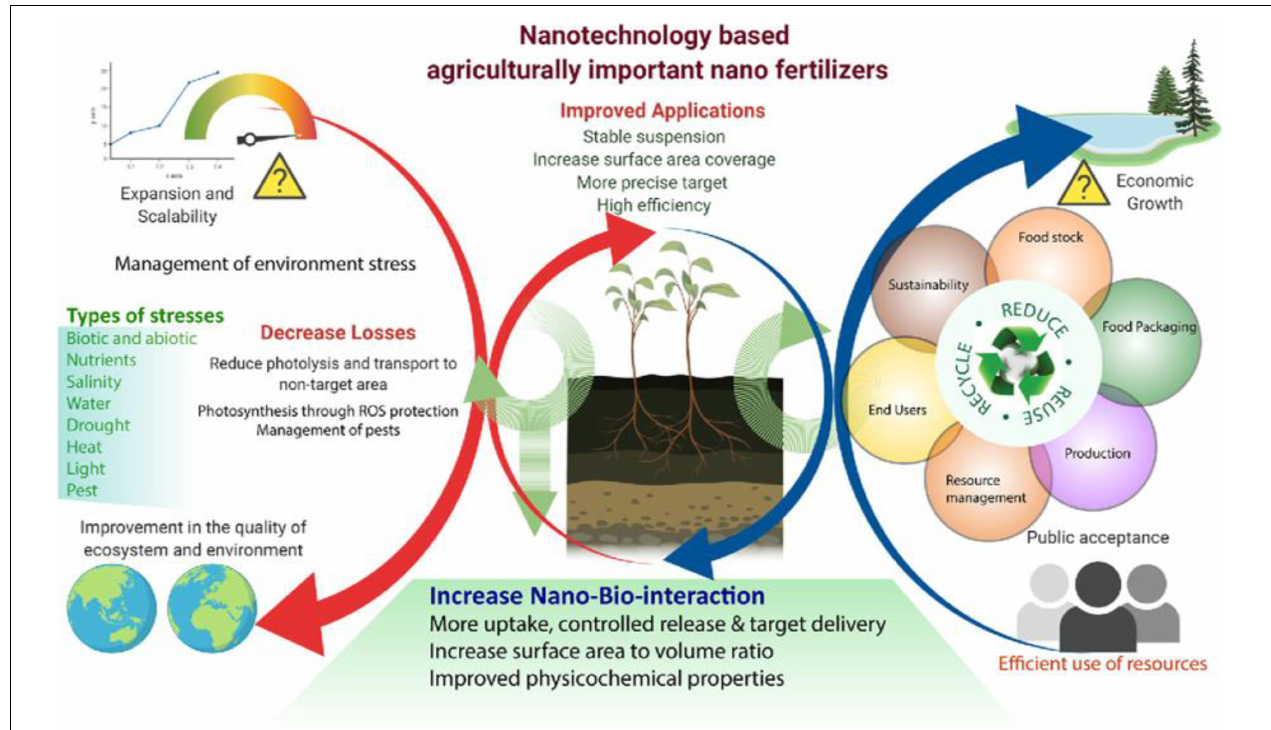
FIGURE 3 | Nanotechnology-based agriculturally important nano-fertilizers, which are increasing the agronomic productivity, efficiency, and reduce environmental stress. Although showed the improved applications in agriculture by nanotechnology and Types of stresses overcome by nanotechnology. Reproduced with permission from Mittal et al. (2020)